Question: Give a one-sentence summary of this figure.
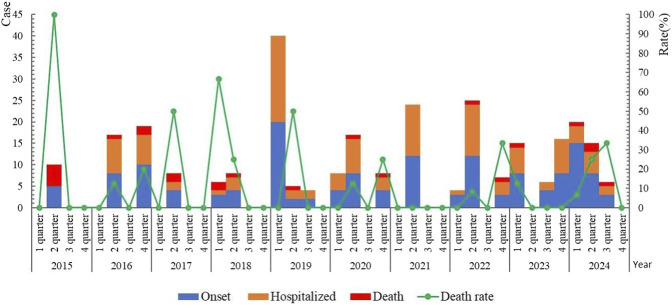
Answer: Joinpoint regression analysis of Gelsemium poisoning in Guangxi, 2015–2024.